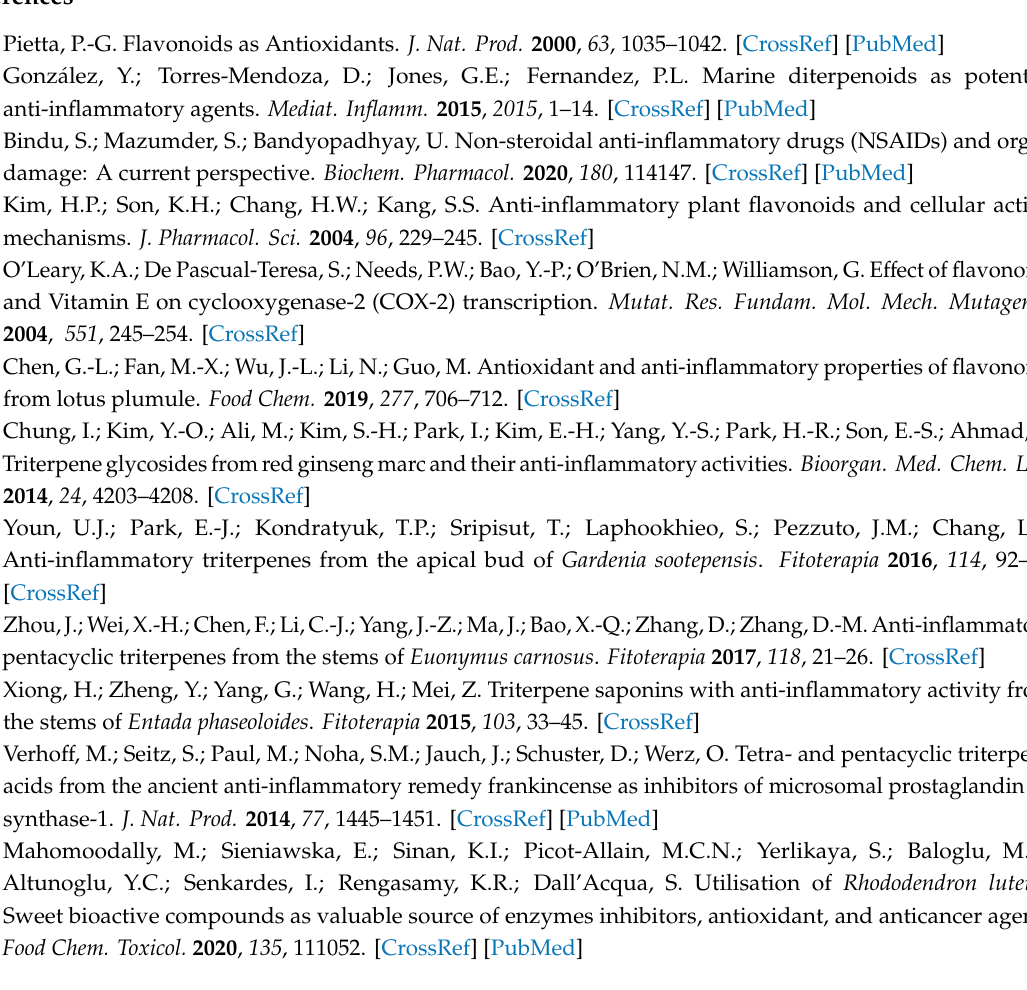
Table S1: Summary of optimized LC-MS / MS parameters used for the qualitative analysis of phenolic acids and flavonoids in the MRM scan mode, Table S2: Analytical parameters applied in the LC-MS / MS quantitative method, Figure S1: LC-ESI-MS / MS chromatograms (the MRM mode) of flavonoid aglycones found in sample RL140C-M; Monitored MRM transition is given in the bracket: 1—catechin ( m / z 288.8 → 244.9); 2—taxifolin ( m / z 302.7 → 124.9); 3—myricetin ( m / z 316.7 → 136.9); 4—luteolin ( m / z 284.7 → 132.9); 5—eriodictyol ( m / z 286.7 → 134.9); 6—quercetin ( m / z 300.7 → 150.9); 7—3- O -methylquercetin ( m / z 314.7 →